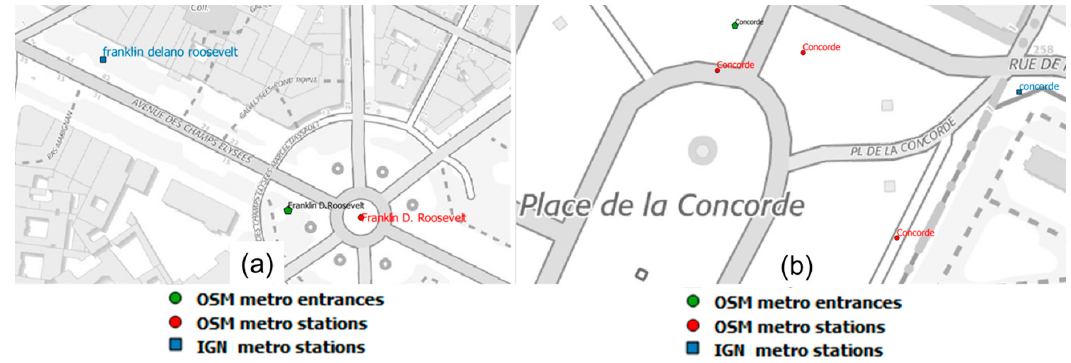
Figure 12. Data matching results: ( a ) wrongly non-matched; ( b ) correctly non-matched Data matching (©OpenStreetMap contributors, ©BDTOPO).